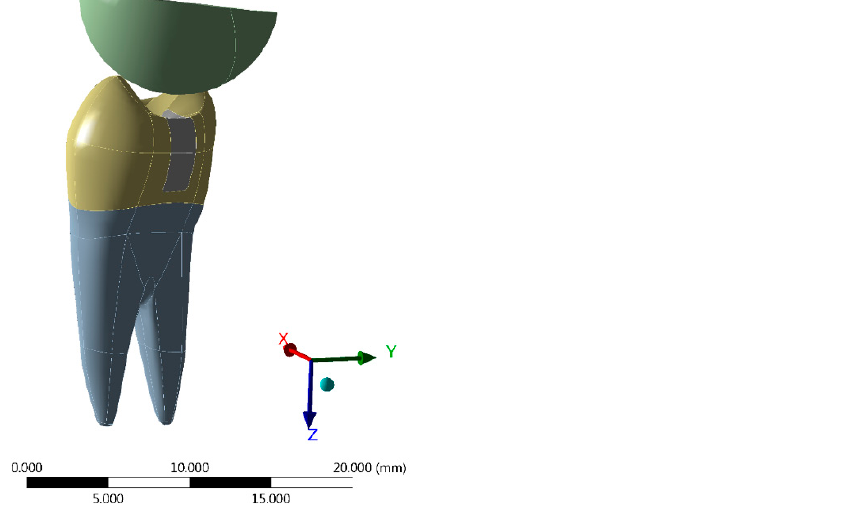
Figure 3. Loading method performed in the present simulation using a stainless steel spherical loading device. Table 2. Mechanical properties of the materials used in the